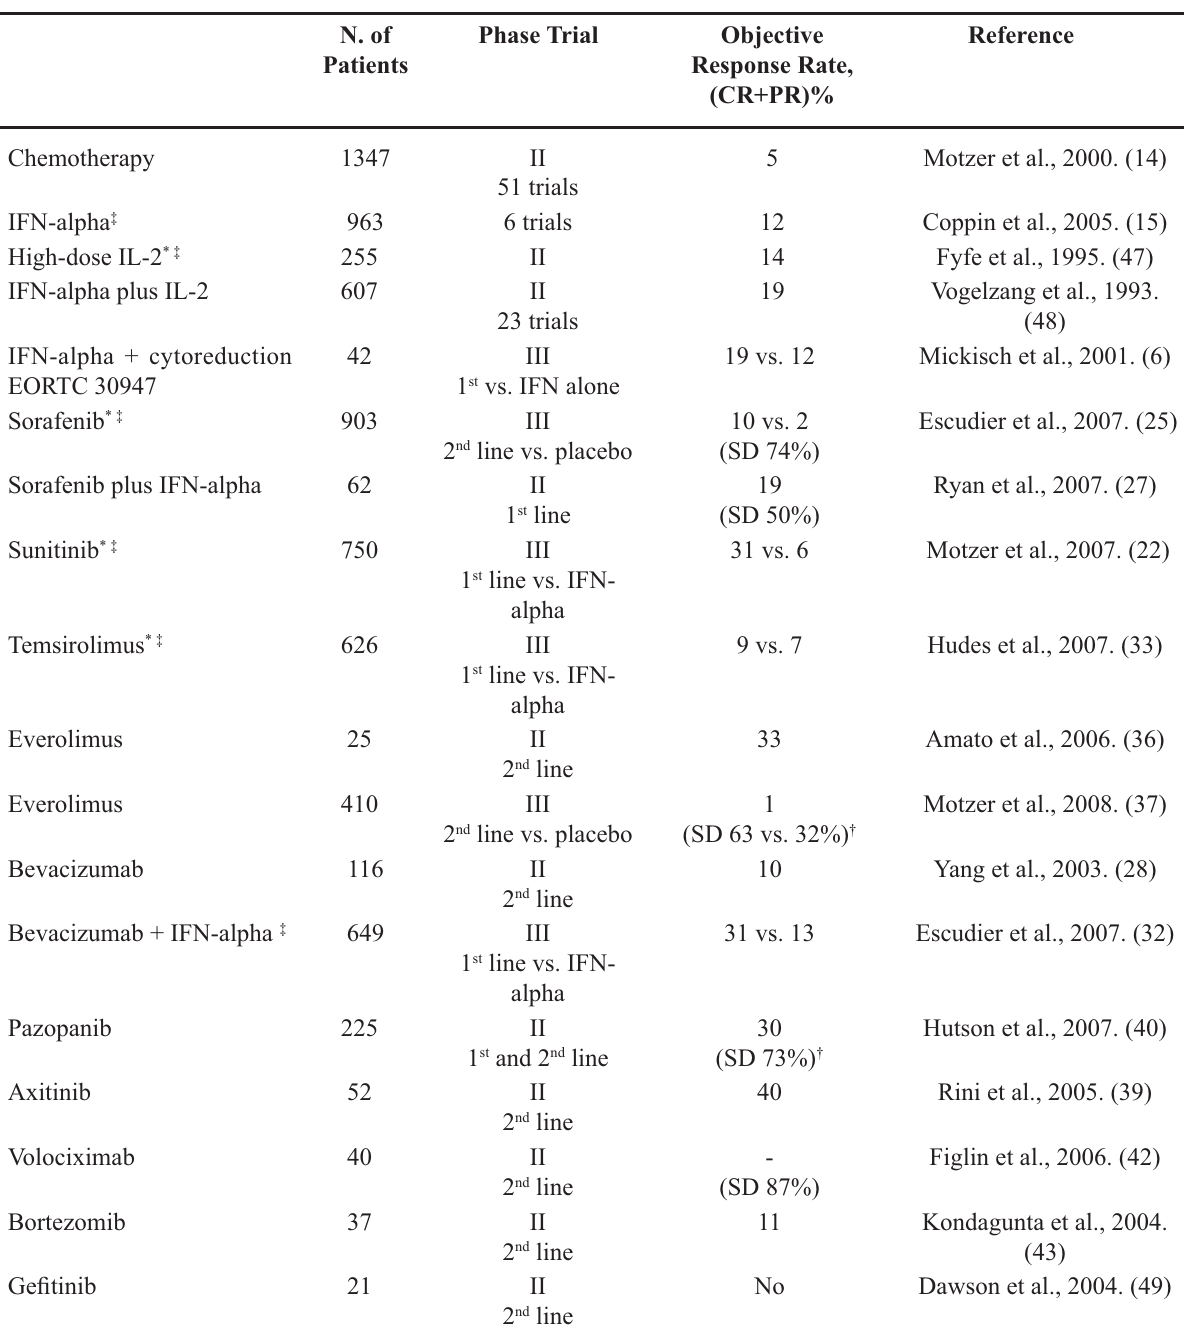
Table 3 – Systemic therapies for metastatic renal cell carcinoma. N.